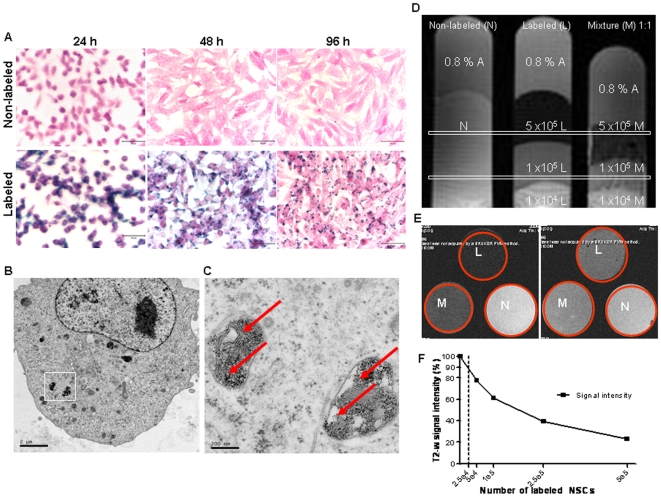
Labeling efficiency of FE-Pro.(A) Light microscopy images of Prussian blue-stained non-labeled and FE-Pro-labeled NSCs at 24, 48 and 96 hours after labeling. (B) Electron micrographs of Fe-Pro-labeled NSCs. (C) Higher magnification image of outlined area in (B). Red arrows point to internalized FE-Pro complex in membrane-bound organelles. (D–E) T2-weighted MR images of labeled (L), non-labeled (N), and an equal mixture (M) of NSCs grown in soft agar. Each phantom contained three different total numbers of NSCs (1×104, 1×105 and 5×105) each in 500 µl of 20% DMEM and 0.8% agar. Coronal view (D) and axial view at 5×105 (E. left) and 1×105 (E. right) of the phantoms. Decrease in T2-w signal strength correlated with the number of labeled cells in the phantom. (F) Graph of T2-w signal intensity vs. number of labeled NSCs. Data were extracted from 5 random fields of each corresponding phantom using ImageJ and shown as mean±SE. MRI conditions: 7.0 Tesla, Gradient-Echo sequence, voxel size = 0.09 mm3, TR/TE = 5402.5/90 ms. Scale bars = 50 µm (A), 2 µm (B) and 200 nm (C).